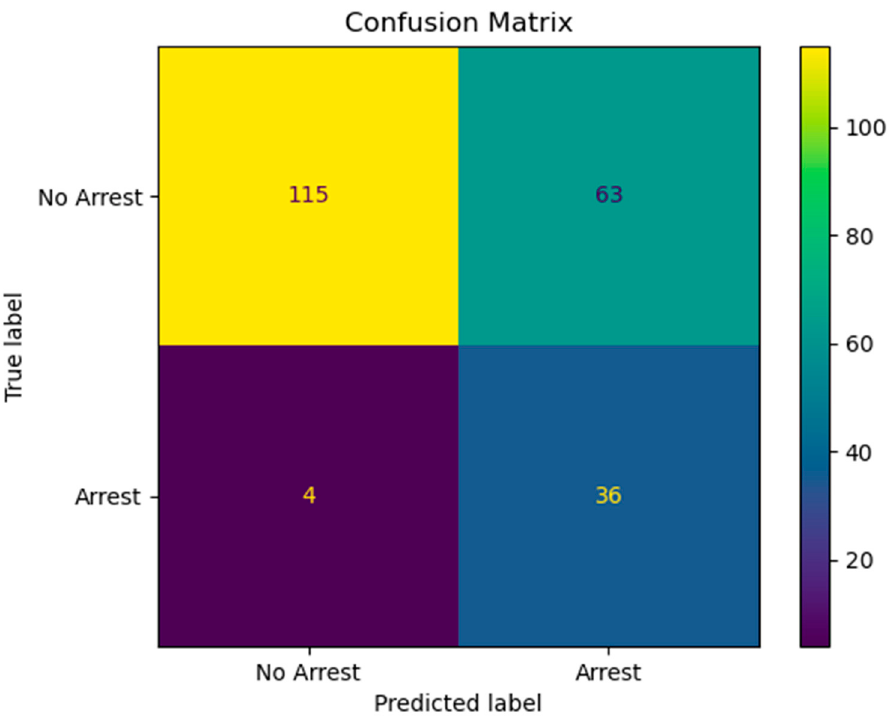
Figure 2. Confusion matrix: the model had a sensitivity of 90% and a specificity of 65%. The model had a positive predictive value of 36% and a negative predictive value of 97%.